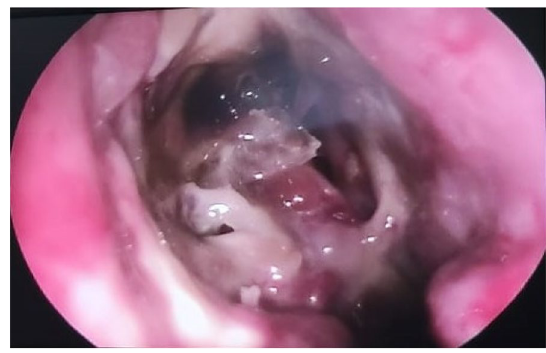
Fig. 2 Nasal endoscopic picture showing black crusts around the necrosed middle turbinate in a CAM patient